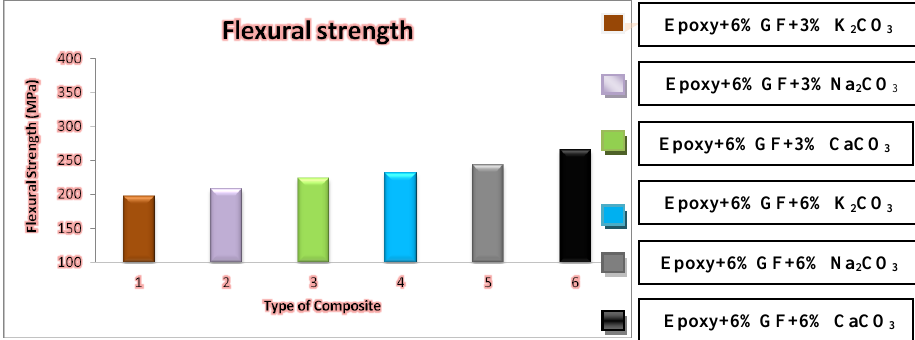
Fig.15: Flexural strength of industrial composites